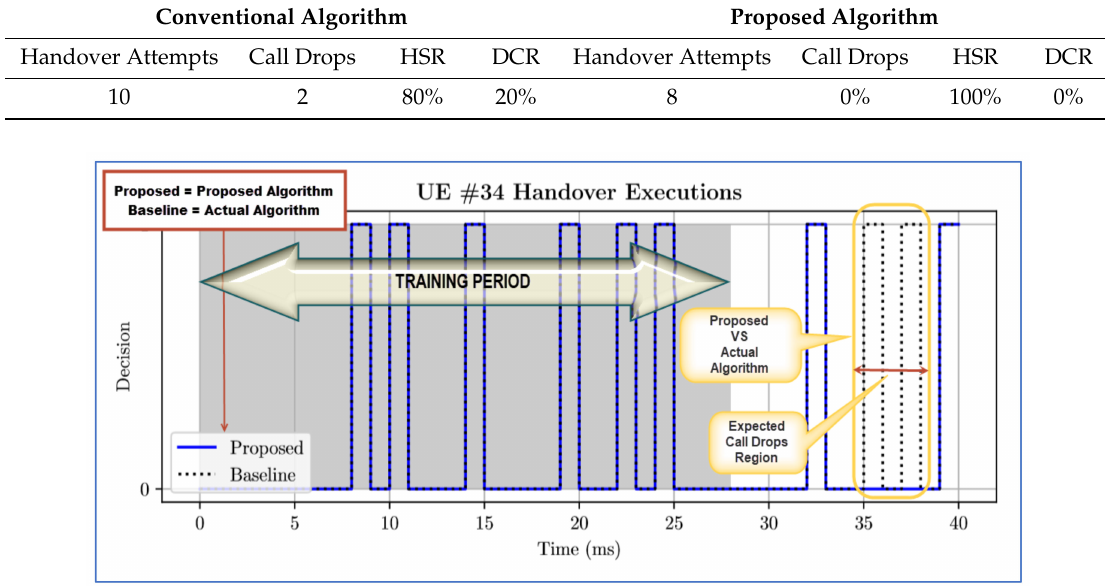
Figure 4. Proposed vs. baseline